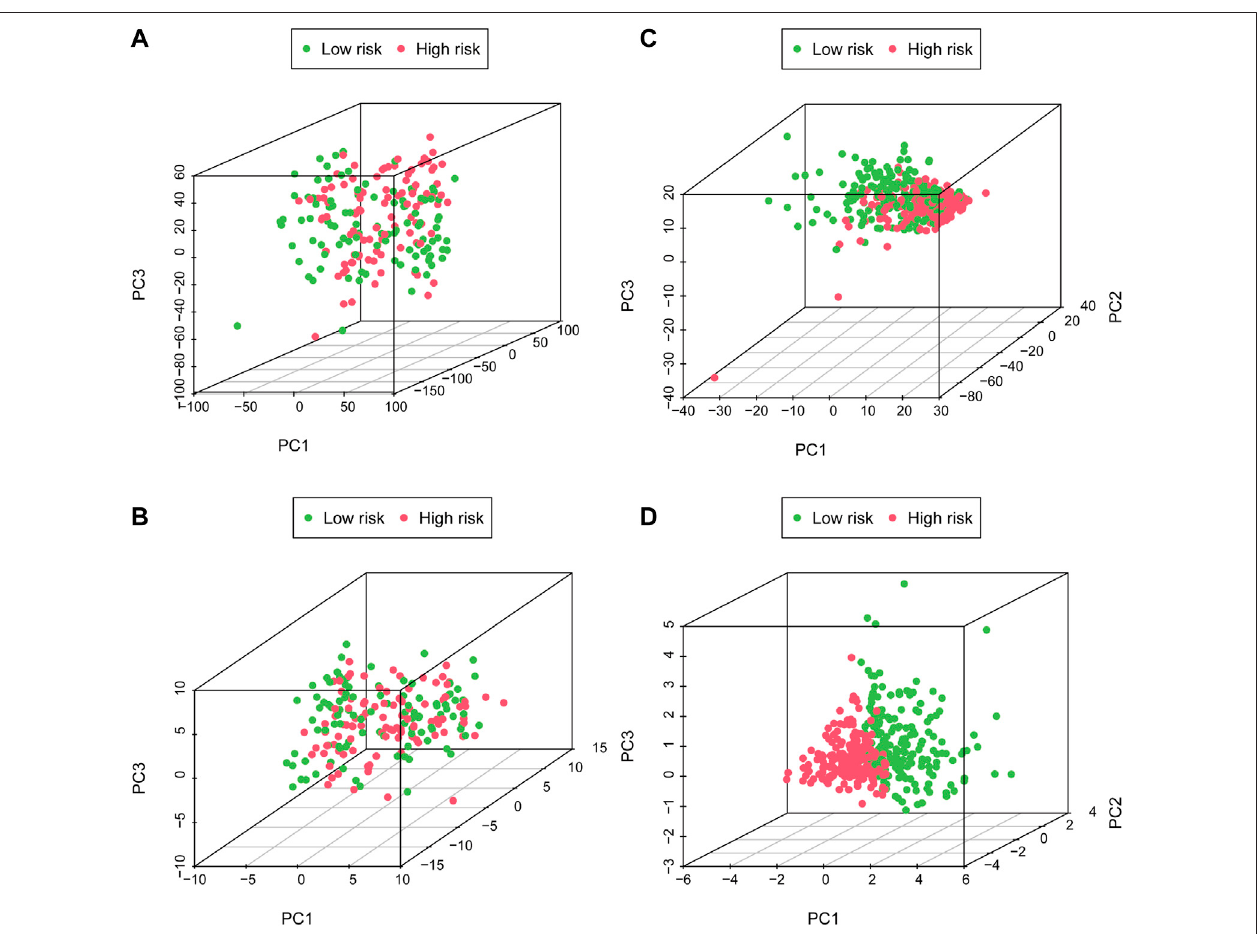
FIGURE5| Thehigh-andlow-riskgroupswithdifferentglycometabolismstatuses. (A – C) PCAbetweenthehigh-andlow-riskgroupsonbasisofwholegenesets, glycometabolism gene sets and glyco-lncRNAs. (D) PCA between the high- and low-risk groups according to the 6 glyco-lncRNAs.